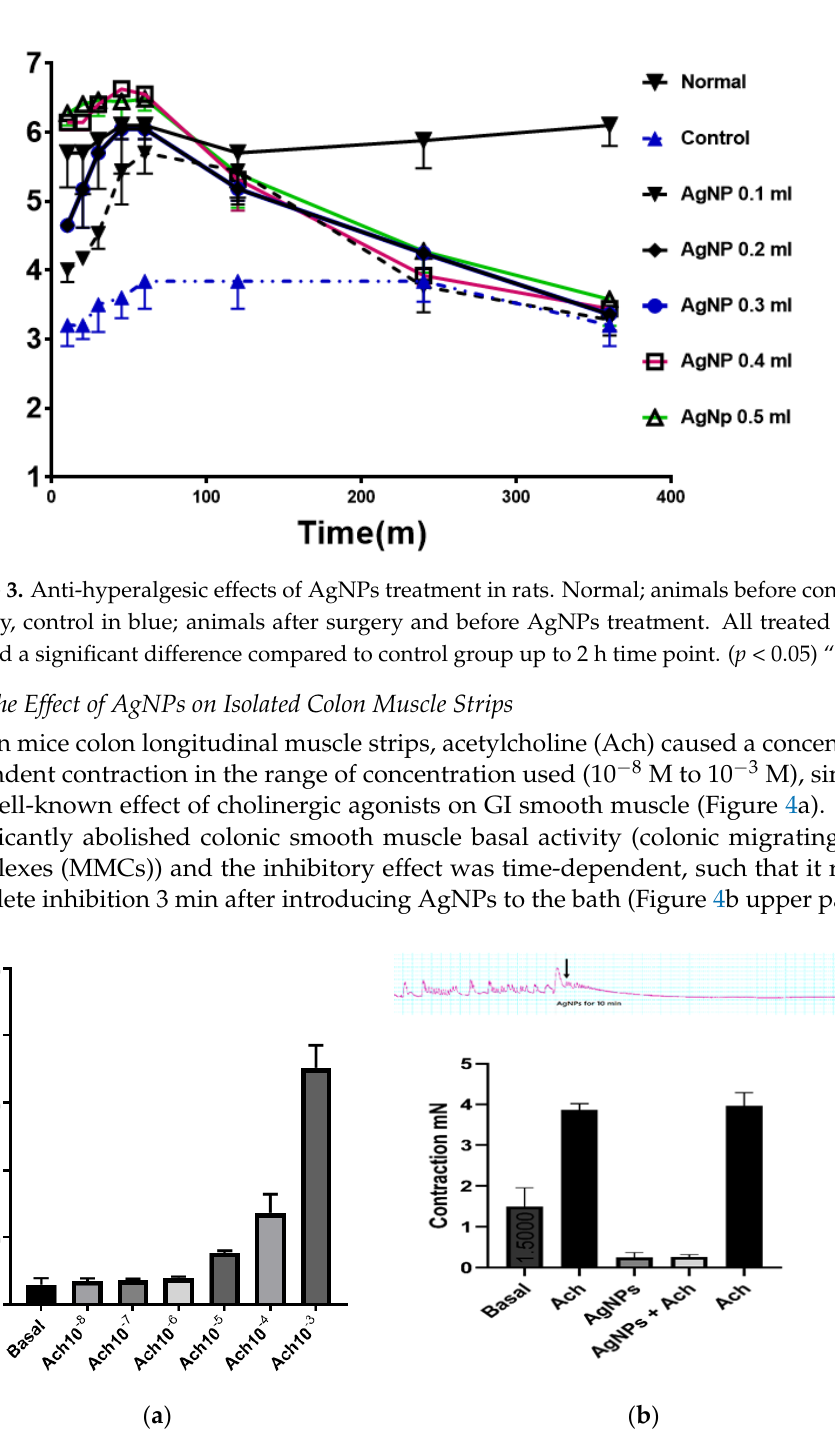
Figure 4. AgNPs abolished colonic migrating motor complexes (MMCs) and acetylcholine (Ach)-induced contractions. ( a ) Ach produced concentration-dependent contraction in the range of concentration used (10 − 8 M to 10 − 3 M). ( b ) Upper panel, AgNPs (8 µg/mL) abolished MMCs colonic activity in a time-dependent manner and prevented Ach-induced contraction; B lower panel, summary of data of the effect of AgNPs on MMCs and Ach-induced at Ach (10 − 5 M) contraction.